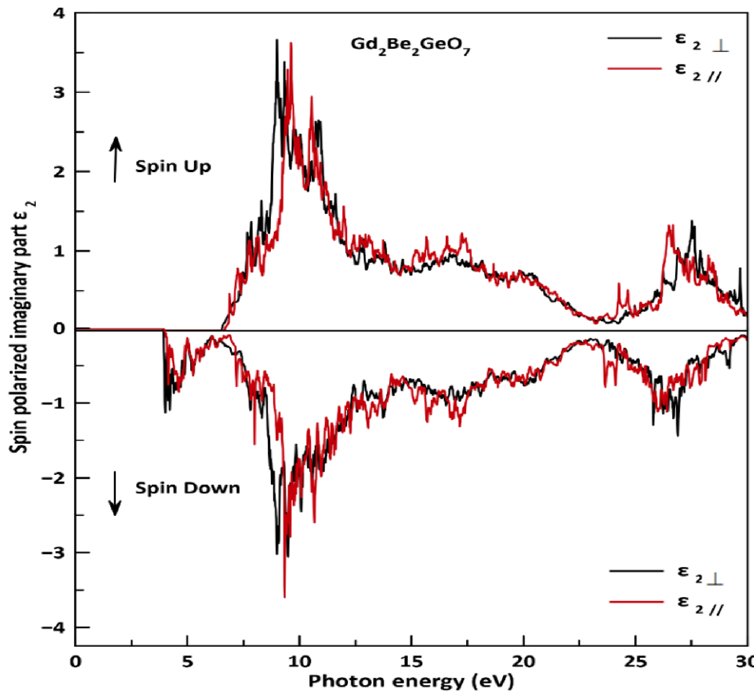
Figure 6. The spin- polarized optical calculations using GGA + mBJ for Gd 2 Be 2 GeO 7 compound.